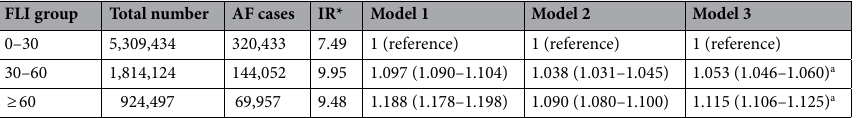
Table 2. Hazard ratios of the fatty liver index for incident atrial fibrillation. Model 1: age sex. Model 2: Model 1 + hypertension, diabetes, dyslipidemia, chronic kidney disease, smoking, alcohol consumption, exercise, low income. Model 3: Model 2 + systolic blood pressure, total cholesterol, fasting glucose. AF atrial fibrillation, FLI fatty liver index, IR incidence rate. *IR, incidence rate (per 1000 person-years). a Bonferroni-corrected significance level of p < 0.004 was used for multiple